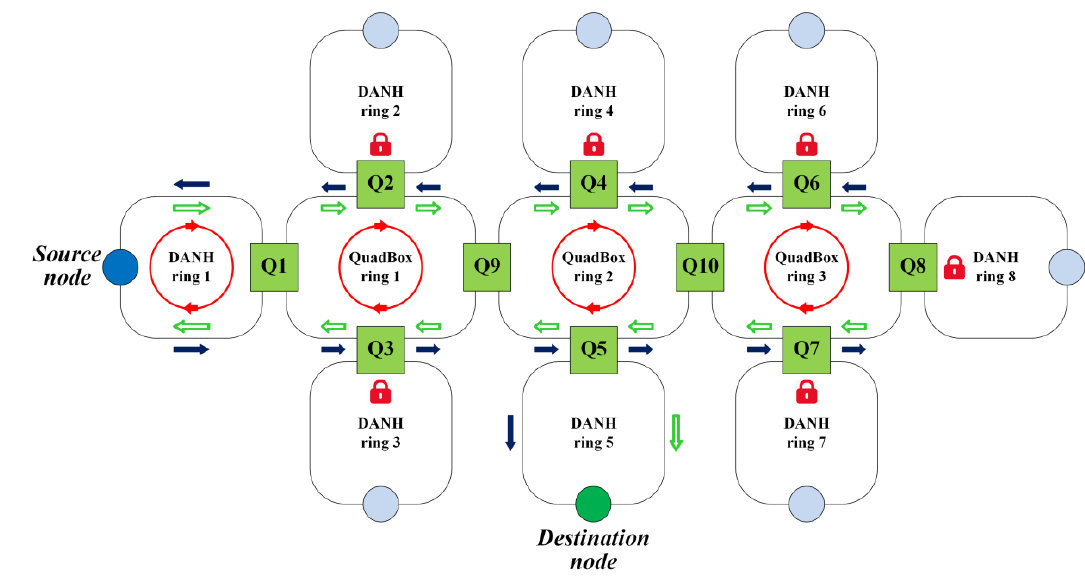
Figure 13. Network traffic under the PL approach in Case